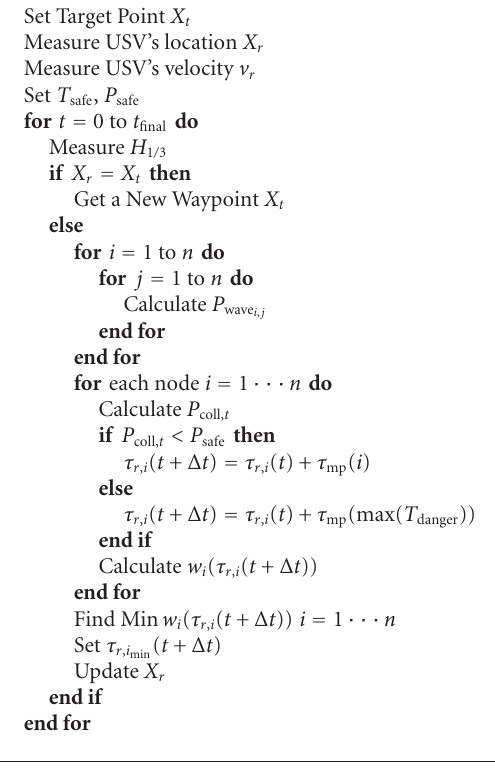
Algorithm 1: Planner